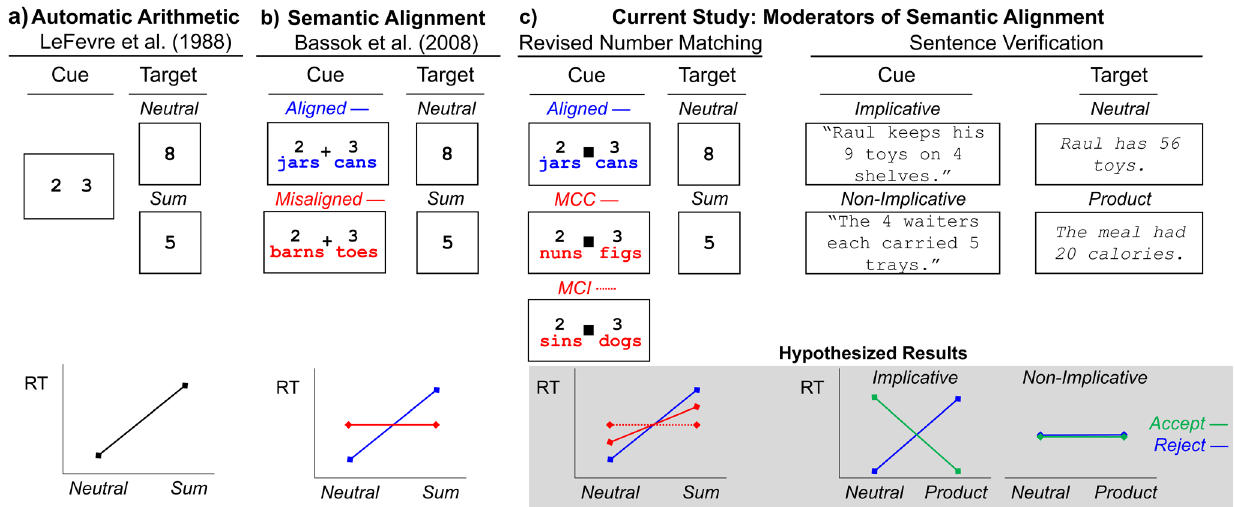
Figure 1. Priming effects for a) automatic arithmetic without context where participants match the target digit to preceding cue digits (LeFevre interference effect), b) the LeFevre interference effect moderated by the presence of categorically aligned or misaligned nouns (Bassok effect), and c) hypothesized moderators of semantic alignment examined in the present study. Our revised Number Matching task was inspired by Bassok et al. (2008); we extended it to compare types of misalignment that we differentiated as Misaligned Concrete-Concrete (MCC) and Misaligned Concrete-Intangible (MCI) noun sets. NOTE: Only rejection trials are graphed, for all three matching tasks. Our Sentence Verification task employed a similar priming paradigm, with the judgment being whether to accept or reject the target prompt statement as likely to be true, based on the cue statement, and with cue sentences either implicating multiplication or